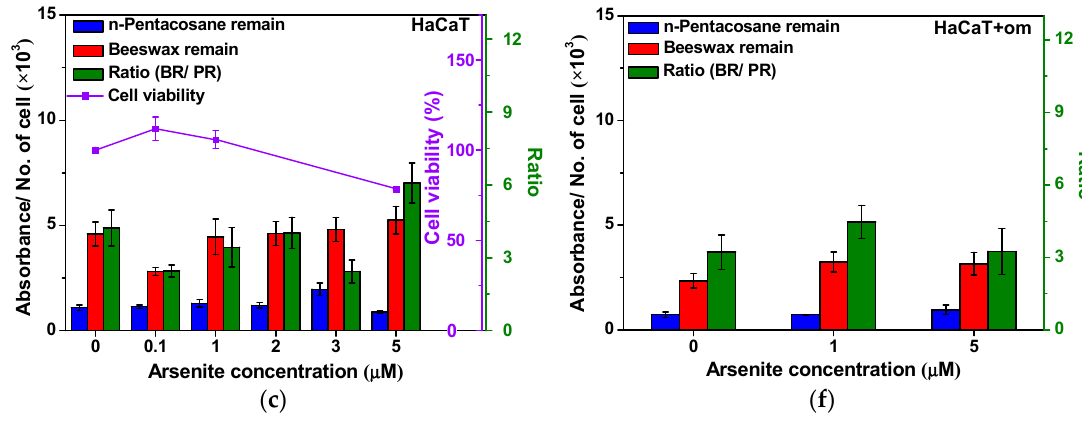
Figure 3. A representative profile of average amount of wax adsorbent remaining adhered on the cell surface of a single cell (blue and red column, left axis) acquired by WPK-FPA-FTIR imaging and cell viabilities (purple line, right axis with an inner ticks) after treating with a variety of concentrations of sodium arsenite and co-cultured with oligomycin (om) and sodium arsenite. ( a , d ) KC; ( b , e ) HSC-1; and ( c , f ) HaCaT cells. The glycan residues population ratio (long-chain/short-chain; green column, right axis with an outer ticks) was used to estimate the ratio of beeswax remaining/n-pentacosane remaining (BR/PR) in different cultured conditions.